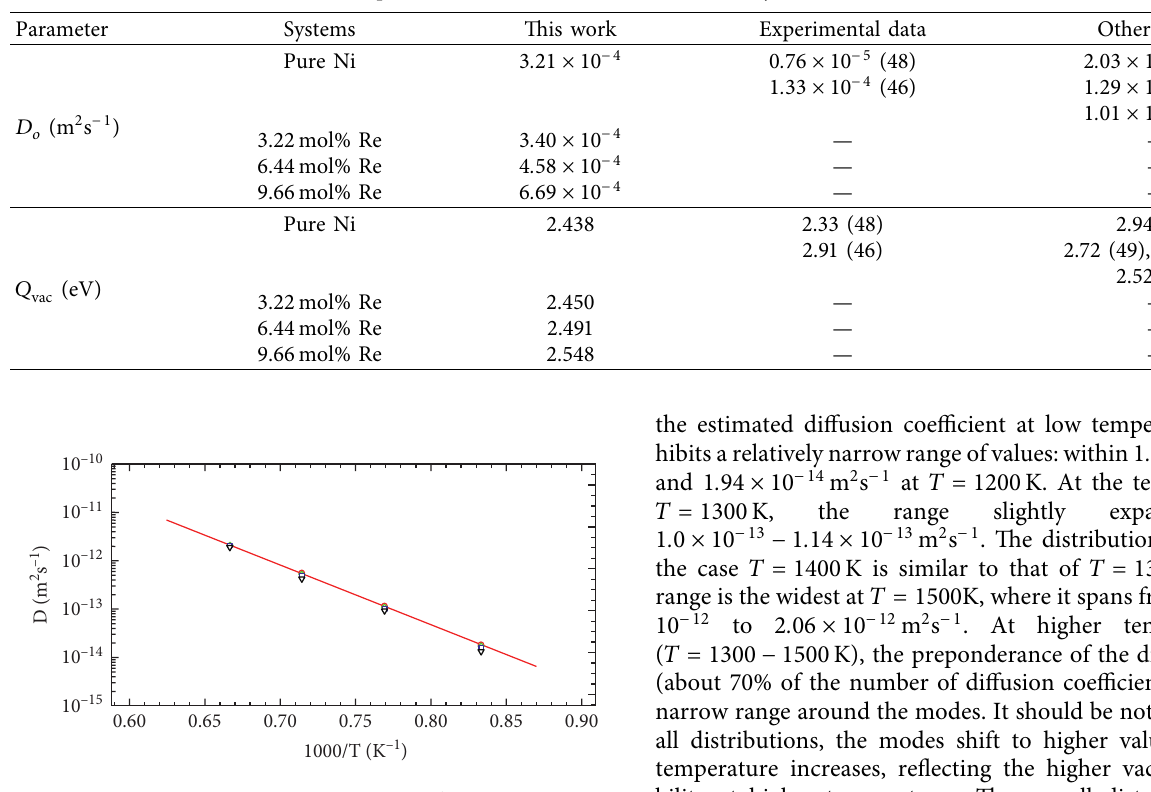
and diffusion prefactors D for the alloying systems investigated. vac 0